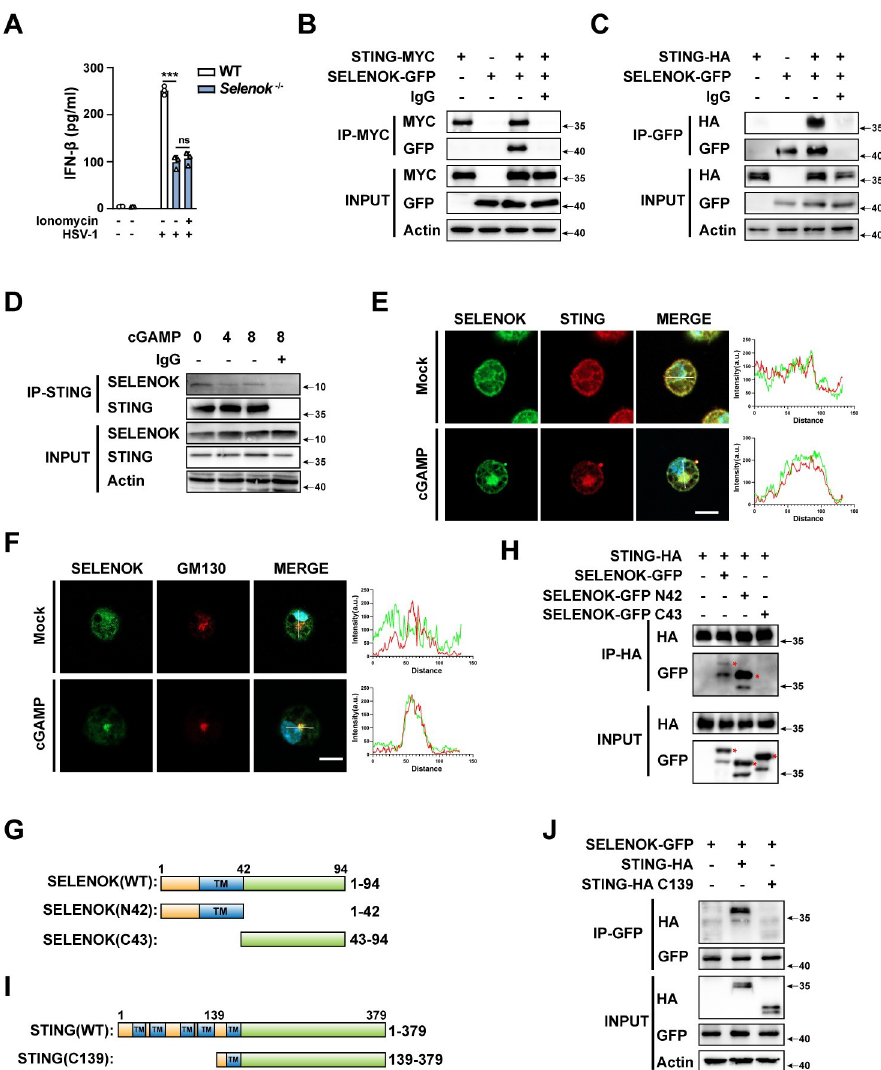
Fig 5. SELENOK interacts with STING. (A) ELISA analysis of IFN- β secretion in PMs from WT and Selenok - deficient mice stimulated with HSV-1 or ionomycin plus HSV-1. (B) Immunoblots of MYC immunoprecipitation in HEK 293T cells transfected with STING-MYC and the control vector or SELENOK-GFP plasmids. (C) Immunoblots of GFP immunoprecipitation in HEK 293T cells transfected with SELENOK-GFP and the control vector or STING-HA plasmids. (D) Immunoprecipitation using a STING-specific antibody in PMs stimulated with cGAMP. (E) Immunofluorescence analysis of PMs stimulated by cGAMP or not using anti-SELENOK (green) and anti-STING (red) antibodies and DAPI nuclear staining. Scale bar,10 μ m. The intensity profiles of each line were quantified by Image J software. (F) Immunofluorescence analysis of PMs stimulated by cGAMP or not using anti-SELENOK (green) and anti-GM130 (red) antibodies and DAPI nuclear staining. Scale bar,10 μ m. The intensity profiles of each line were quantified by Image J software. (G) Schematic of the SELENOK and its truncated body. (H) HA immunoprecipitation in HEK 293T cells transfected with STING-HA and the control vector, SELENOK-GFP, SELENOK-GFP N42, or SELENOK-GFP C43 plasmids. The specific bands were marked by asterisks. (I) Schematic of the STING and its truncated body. (J) GFP immunoprecipitation in HEK 293T cells transfected with SELENOK-GFP and the control vector, STING-HA, STING-HA C139. Statistical significance was determined by unpaired two-sided multiple Student’s t-tests in A. Data represent mean ± standard deviation (SD) or one representative image from three independent experiments. ns: not significant; *** P: < 0.001.